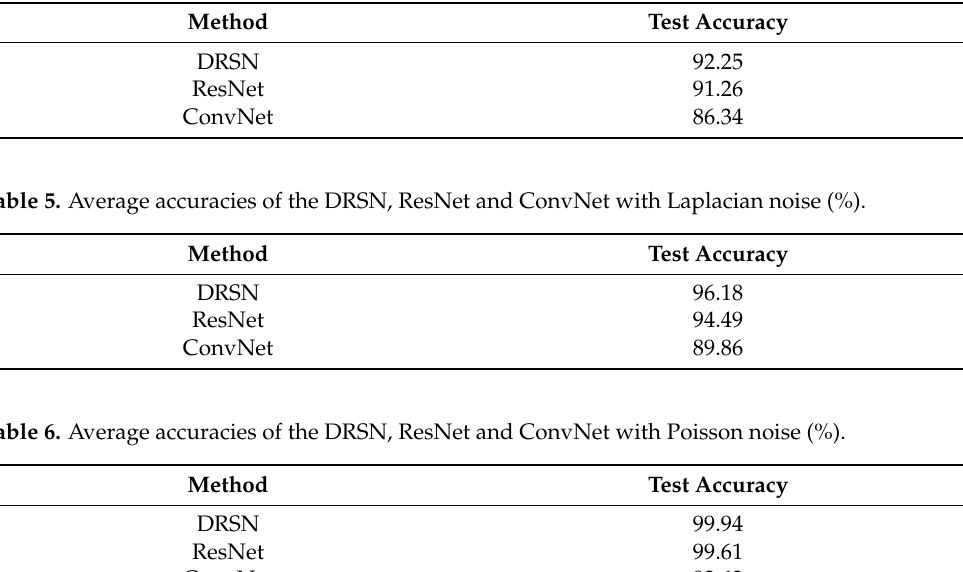
Figure 8. Average recognition rates of DRSN, ResNet and ConvNet under ( a ) Gaussian noise, ( b ) Laplacian noise, ( c ) Poisson noise, and ( d ) Cauchy noise. Table 4. Average accuracies of the DRSN, ResNet and ConvNet with Gaussian noise (%).